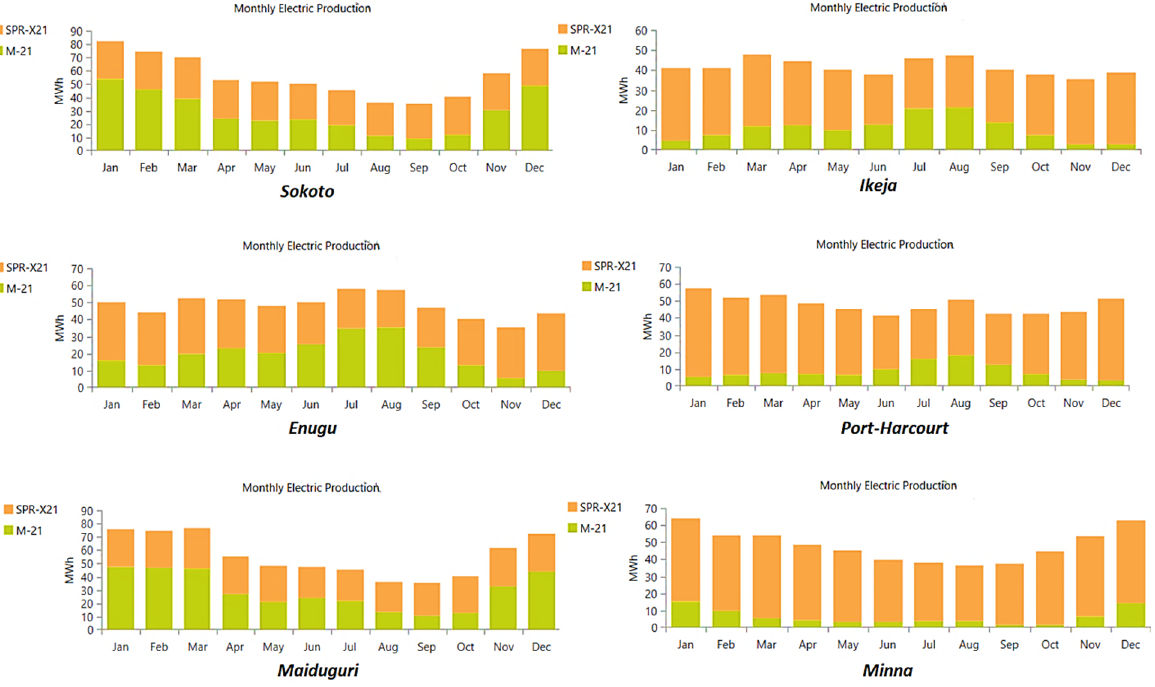
Figure 7. Monthly electricity generated by the PV/WT/battery-based charging station in the six selected sites.